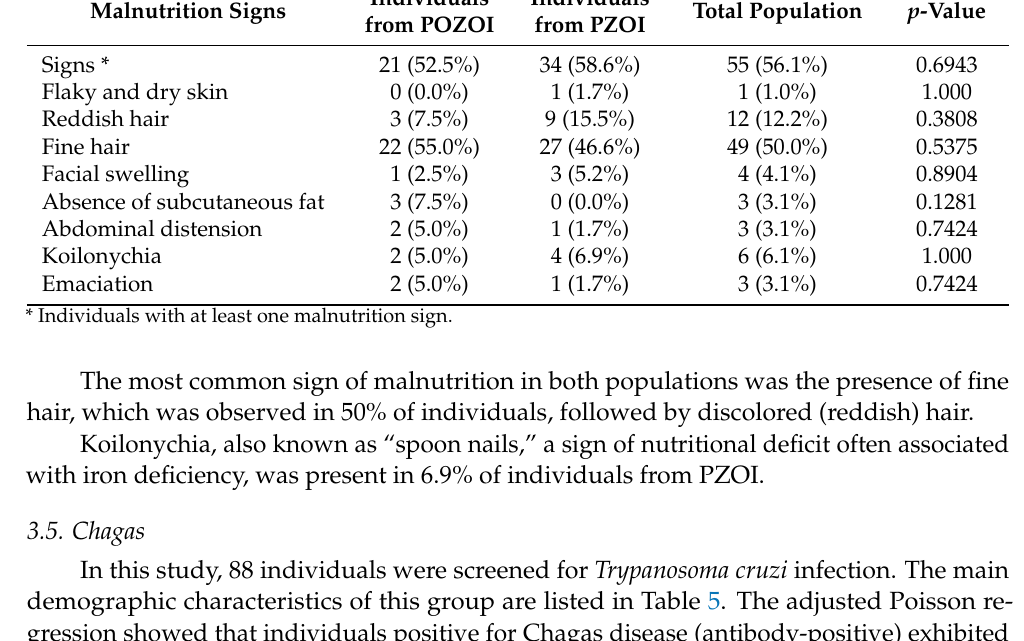
Table 4. Non-parametric chi-squared test for malnutrition signs in the study population. Individuals Individuals Total Population p -Value Malnutrition Signs from POZOI from PZOI Signs * 21 (52.5%) 34 (58.6%) 55 (56.1%) 0.6943 Flaky and dry skin 0 (0.0%) 1 (1.7%) 1 (1.0%) 1.000 Reddish hair 3 (7.5%) 9 (15.5%) 12 (12.2%) 0.3808 Fine hair 22 (55.0%) 27 (46.6%) 49 (50.0%) 0.5375 Facial swelling 1 (2.5%) 3 (5.2%) 4 (4.1%) 0.8904 Absence of subcutaneous fat 3 (7.5%) 0 (0.0%) 3 (3.1%) 0.1281 Abdominal distension 2 (5.0%) 0.7424 Koilonychia 2 (5.0%)